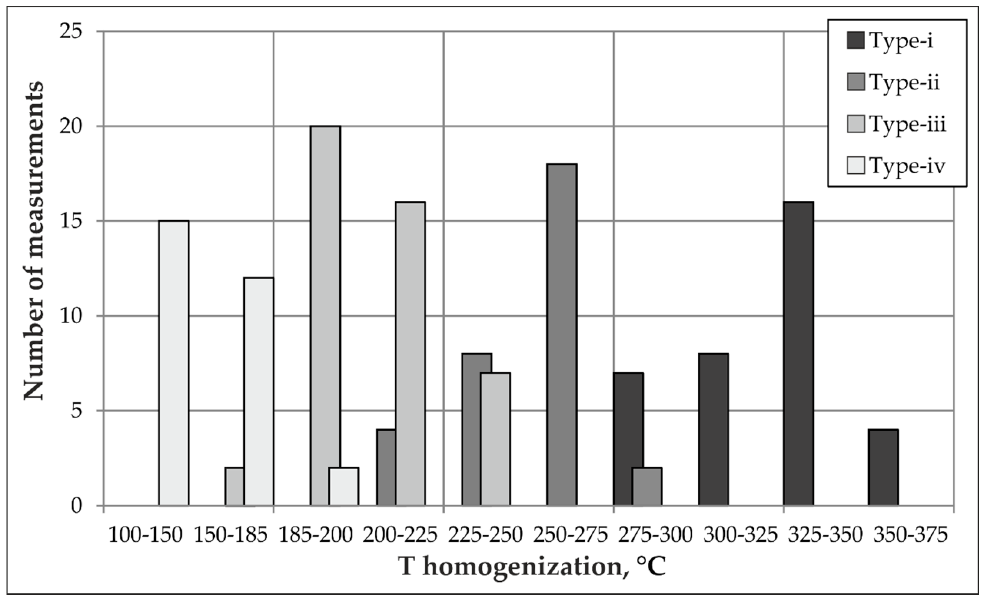
Figure 6. Thermometric data of the fluid inclusion investigations of the ore-related Ba – Sr and REE hydrothermal mineralization of Petyayan-Vara magnesiocarbonatites.